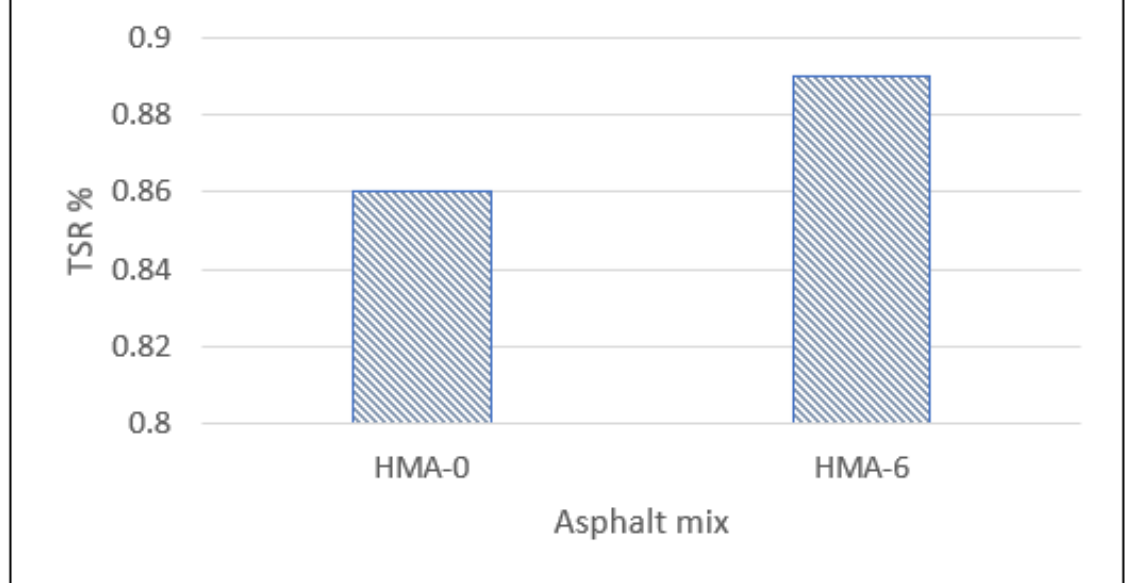
Figure 8. Moisture susceptibility test results.